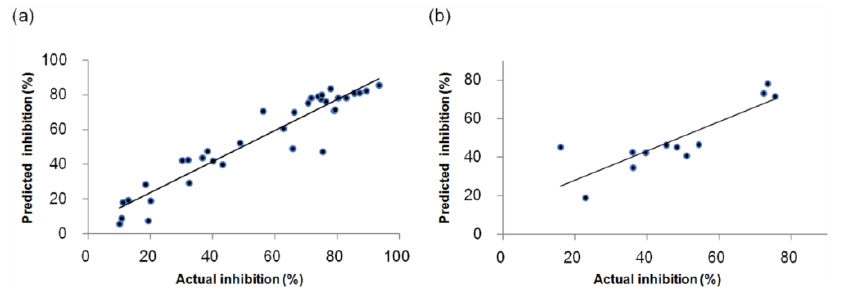
Figure 4. Scatter plots of the actual versus predicted inhibitory activities for the CoMSIA model; ( a ) The training set; ( b ) The test set.